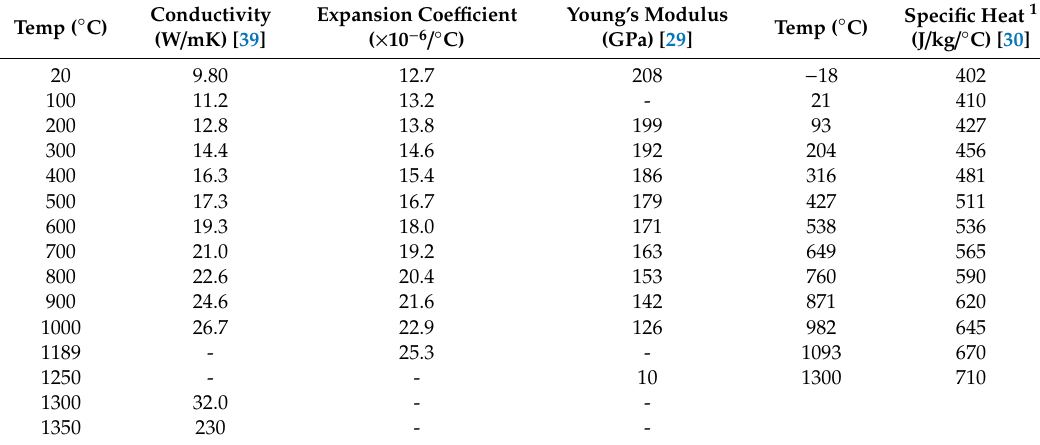
Table 1. Temperature dependent properties of alloy 625.